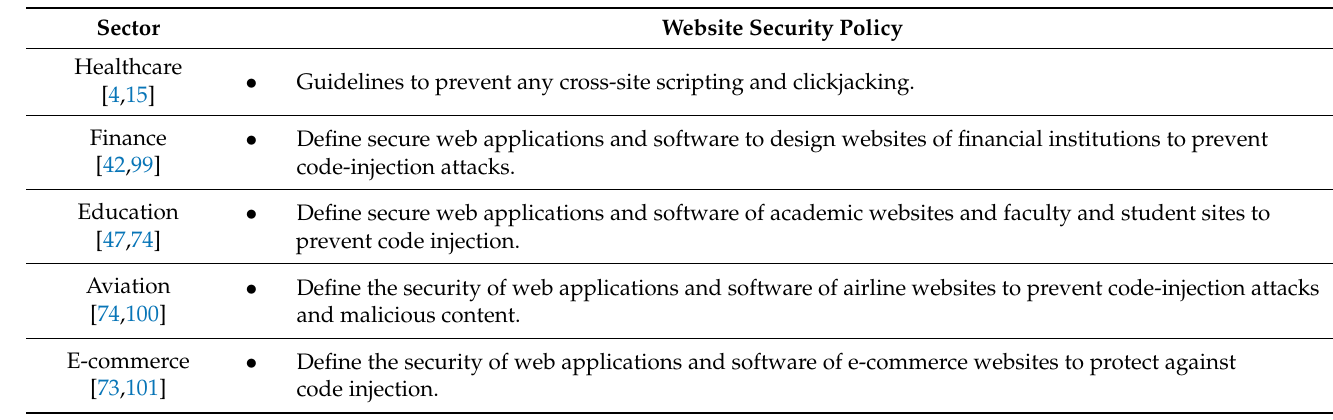
Table 3. Website security policy among different